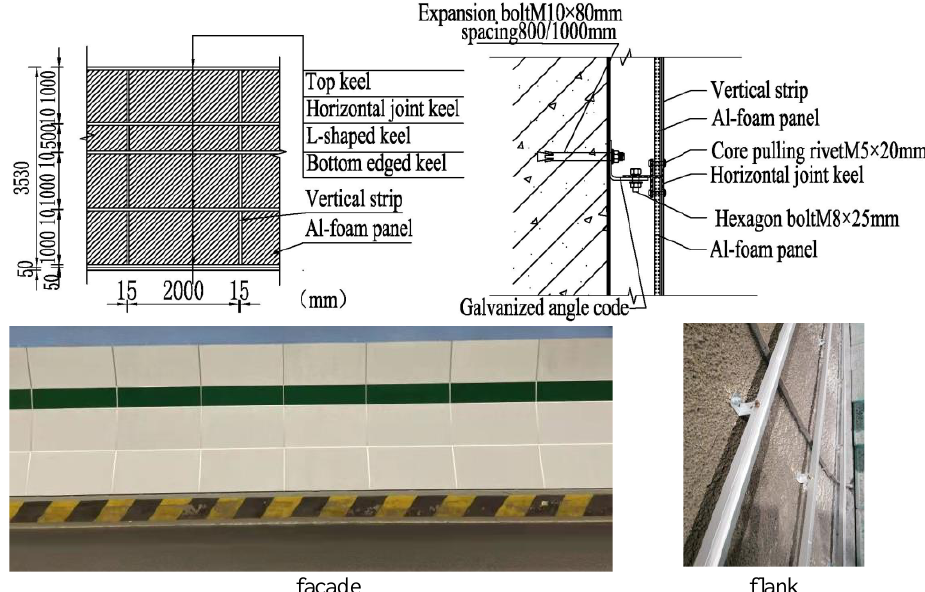
Figure 5. Installation of aluminum foam board in tunnel.